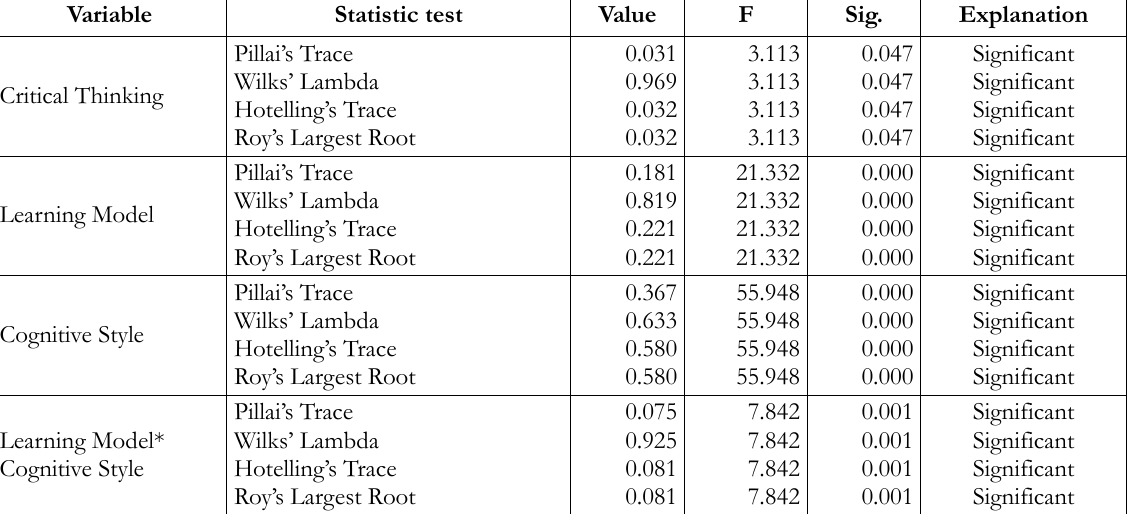
Table 11. Multivariate Tests